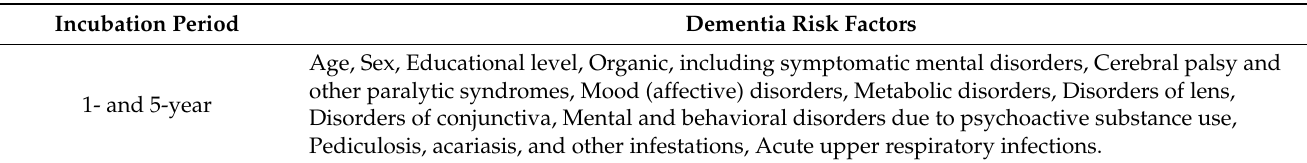
Table 10. Common dementia risk factors shared between the 1- and 5-year incubation period